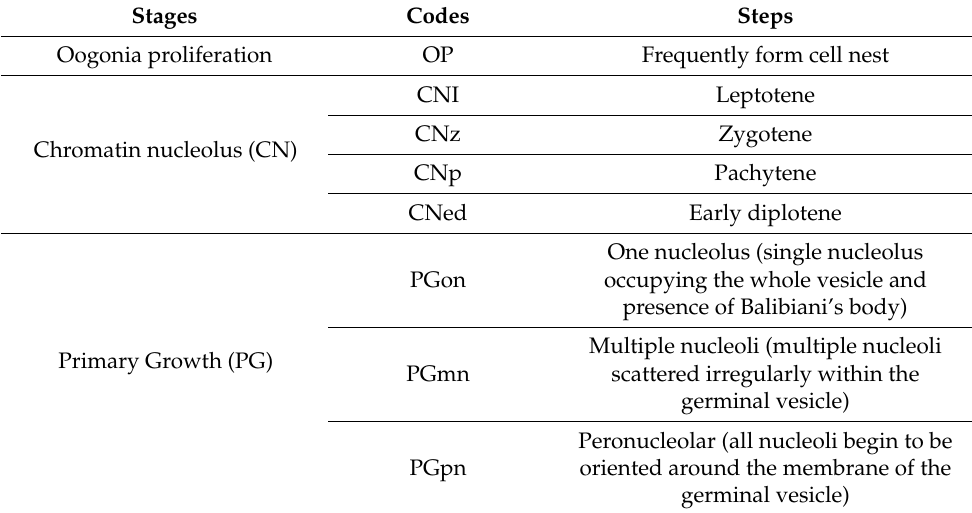
Table 1. Division of oocyte development into three level: periods, stages, steps